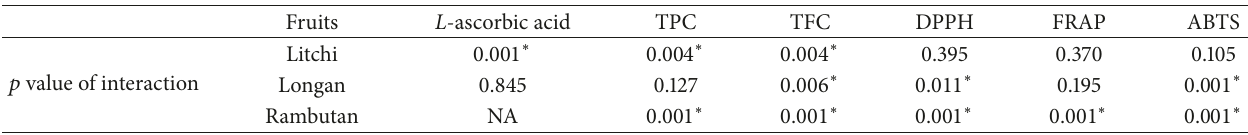
Table 3: 𝑝 value of interaction between treatments and fruit forms shown in examined parameters in litchi, longan, and rambutan tested by two-way